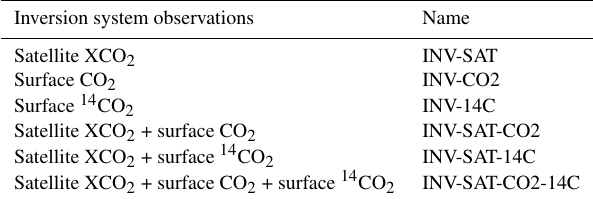
Table 6. List of performed